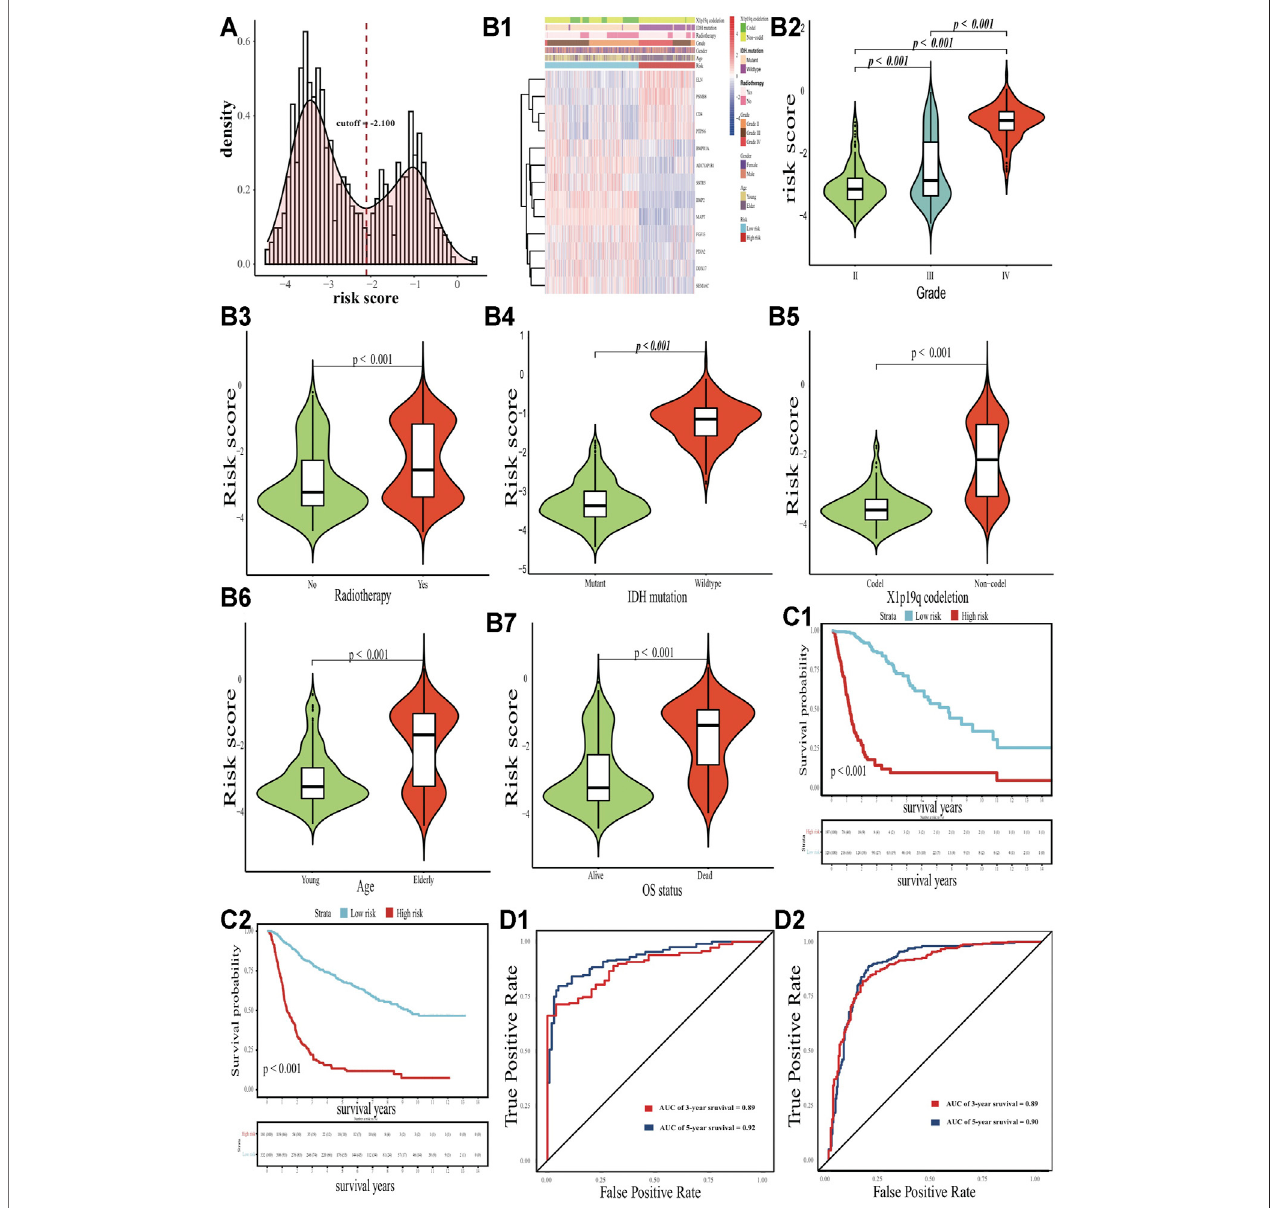
FIGURE 3 | Clinicopathological differences with eRNA-related risk signature. (A) Distribution of the risk score. (B) Differences in expression pro fi le, grade, radiotherapy status, IDH status, X1p19q status, age and survival status. (C1-C2) Kaplan-Meier curves for the TCGA and CGGA cohort, respectively. (D1-D2) ROC curves for the TCGA and CGGA cohort,